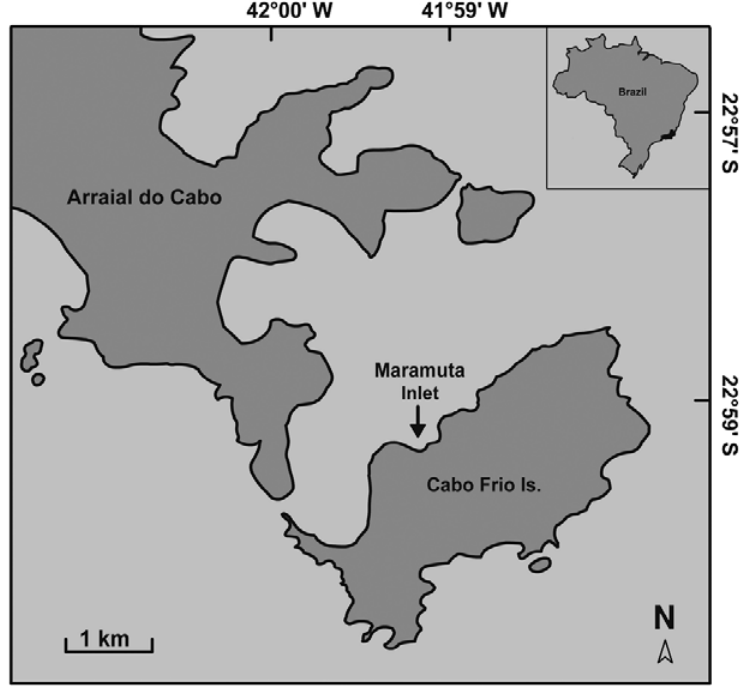
Fig. 1 – Map showing Maramutá Inlet on Cabo Frio Island at Arraial do